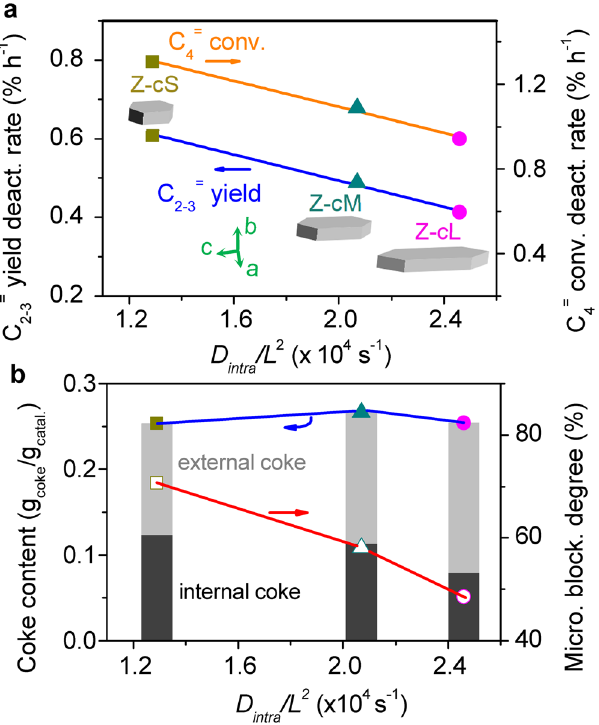
Fig. 7 The relationships between the intracrystalline diffusivity with the OCC activity losses and the coke depositions. a Correlation of C 4 = conversions and C 2-3 = yield deactivation rates with the intracrystalline diffusive rates of butene molecules in H-ZSM-5 crystals. The deactivation rates were calculated on the basis of the catalytic performances displayed in Fig. 3a, b. The data between 20 and 50 h were chosen due to the actual deactivation time. b The coke depositions and the micropore blockage degrees after 50 h of OCC reactions. The error bars are smaller than the data